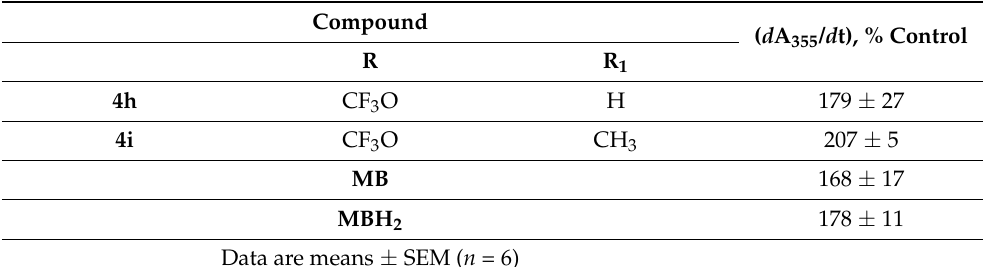
Table 6. The effect of 100 µ M MB , MBH 2 , and lead compounds 4i and 4h on the tubulin polymeriza- tion rate ( d A 355 / d t).